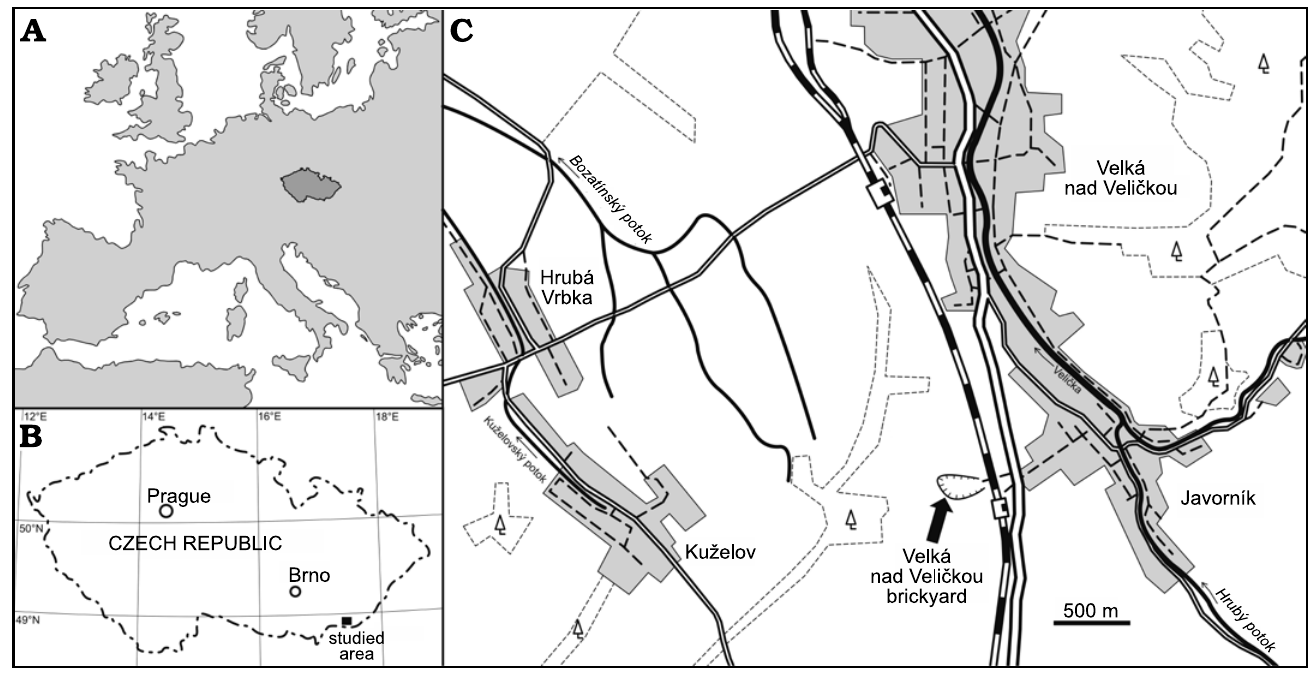
Fig. 1. Location of the studied area in Europe ( A ) and the Czech Republic ( B ). Schematic map of the studied locality ( C